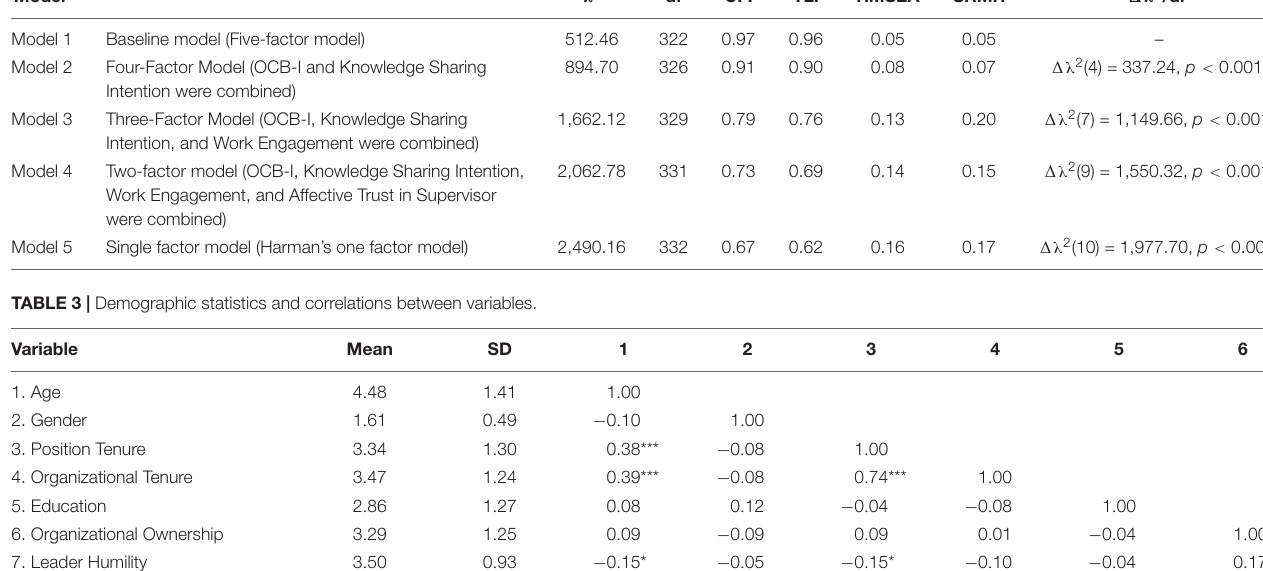
TABLE 2 | Comparison of fit of the hypothesized model with alternative models. Model